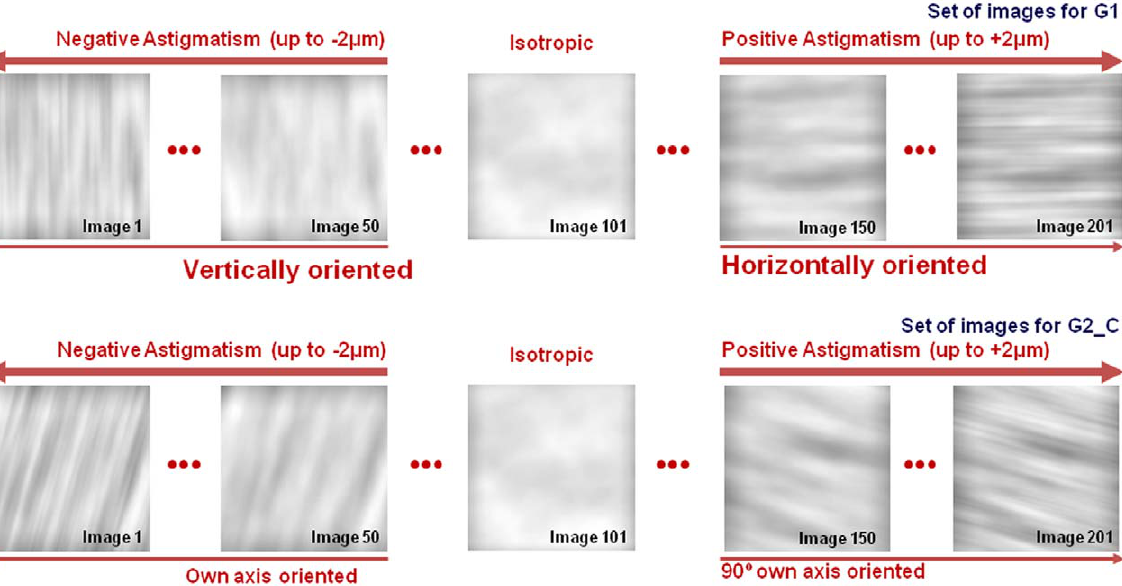
Figure 1. Examples of test images series. Astigmatic blur was generated by varying astigmatism (from 2 2 m m to + 2 m m), and defocus to maintain constant blur strength (B=1.5 D). Image 101 was isotropically blurred. Top panel: image series presented to all subjects from G1, with vertically oriented blur (images 1–100) to horizontally oriented blur (images 102 to 201). Bottom panel: an example of image series presented to G2/ G3 (the example corresponds to G2_C in particular, with images blurred along the axis of natural astigmatism of the eye (75 u ) to a 90 u rotated axis (165 u ).